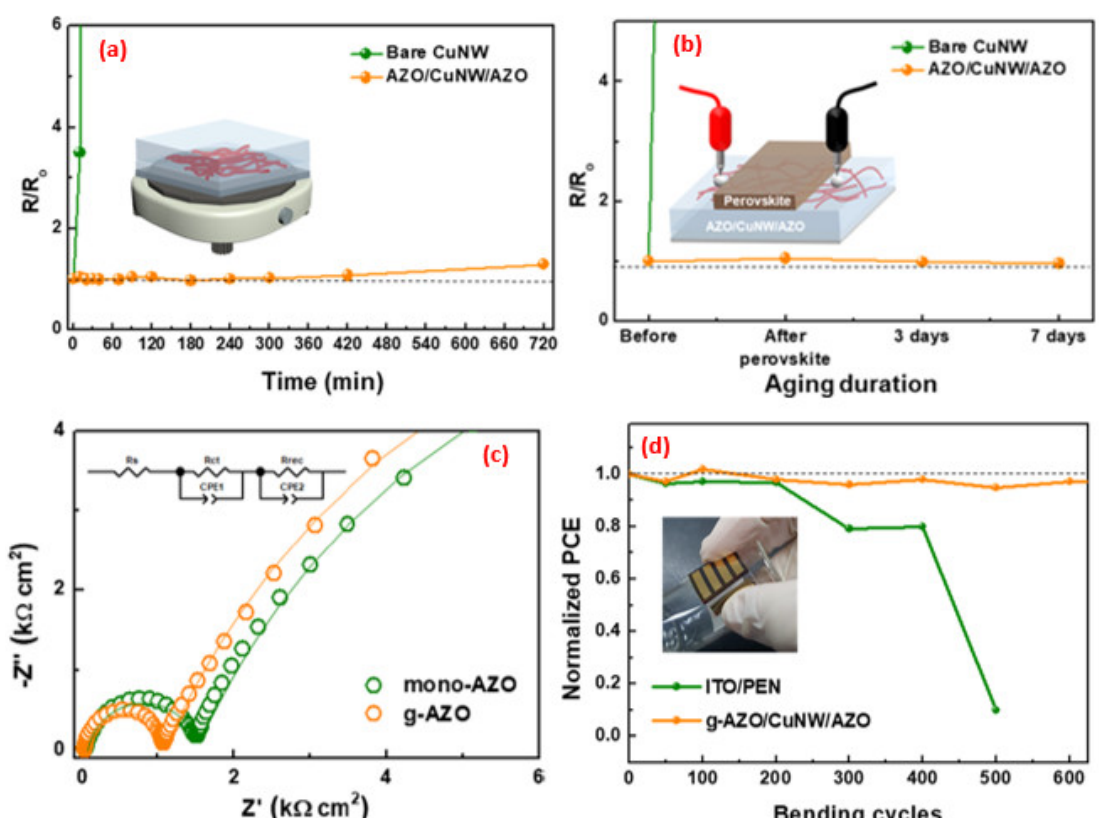
Figure 12. Sheet-resistance variation ( a ) at ambient conditions of 120 ◦ C for the bare CuNW film and AZO-based composite electrode as a function of the annealing time; ( b ) annealing after the spin-coating of the perovskite precursor solution; ( c ) Nyquist plots of flexible PSCs with different electrodes obtained using IS; and ( d ) normalized PCEs of flexible PSCs with indium tin oxide/polyethylene naphthalate and g-AZO-based composite electrodes. Copyright 2020 by the American Chemical Society [140].